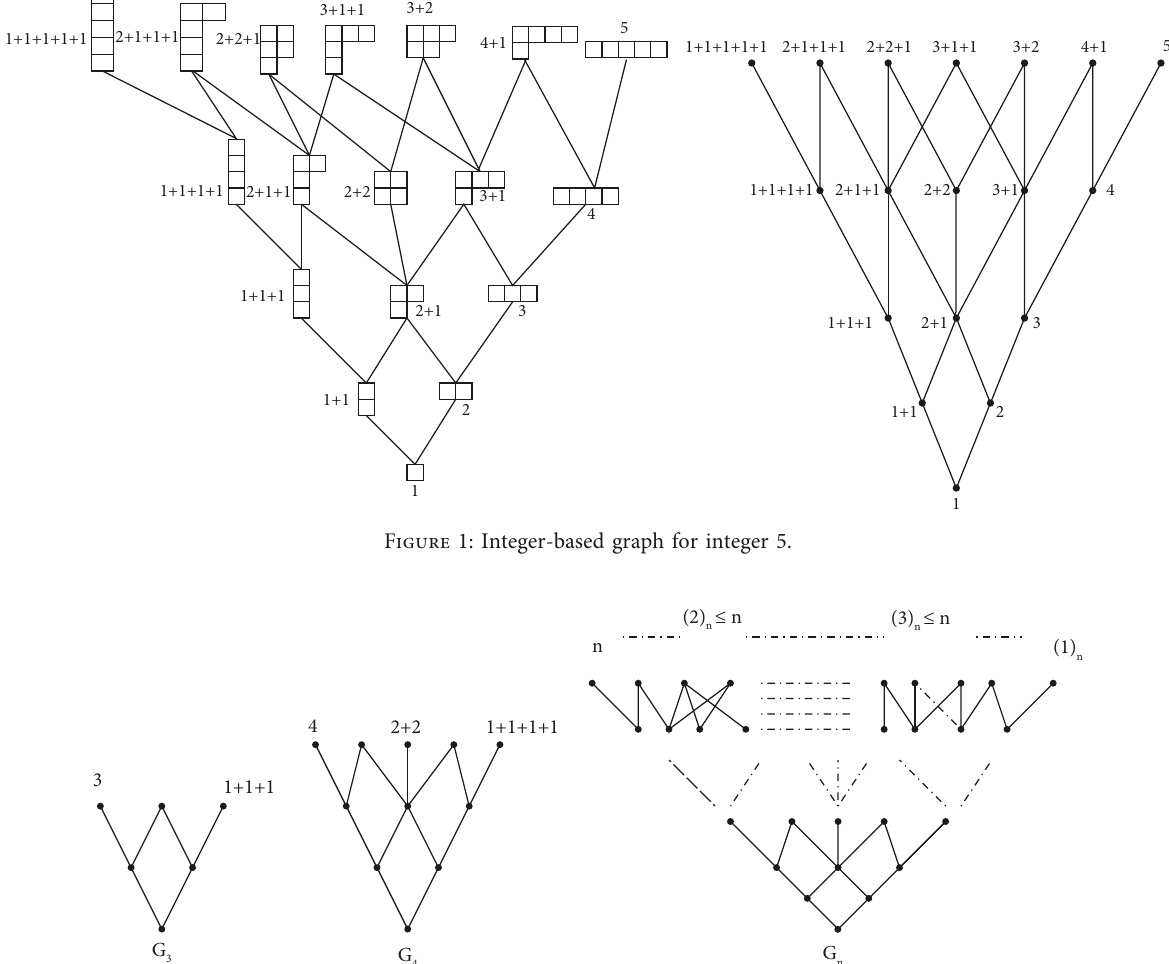
Figure 2: Position of vertices of degree one in integer-based graph.